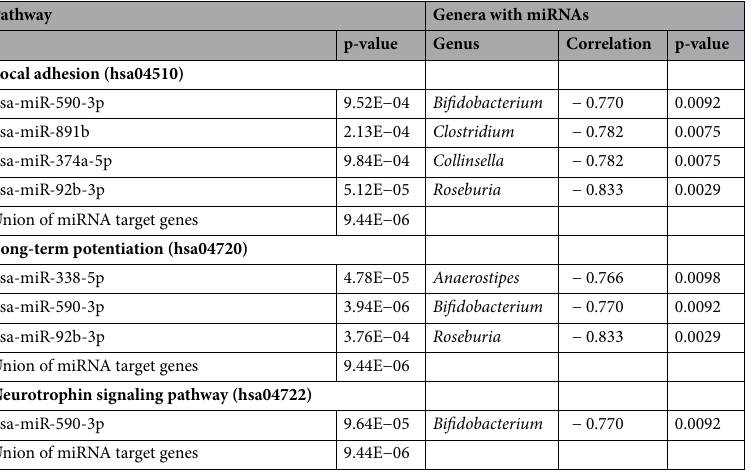
Table 2. Three MDD-associated pathways which were regulated by specific miRNAs of interest. Six MDD- associated genera showed significantly negative correlations with these miRNAs.